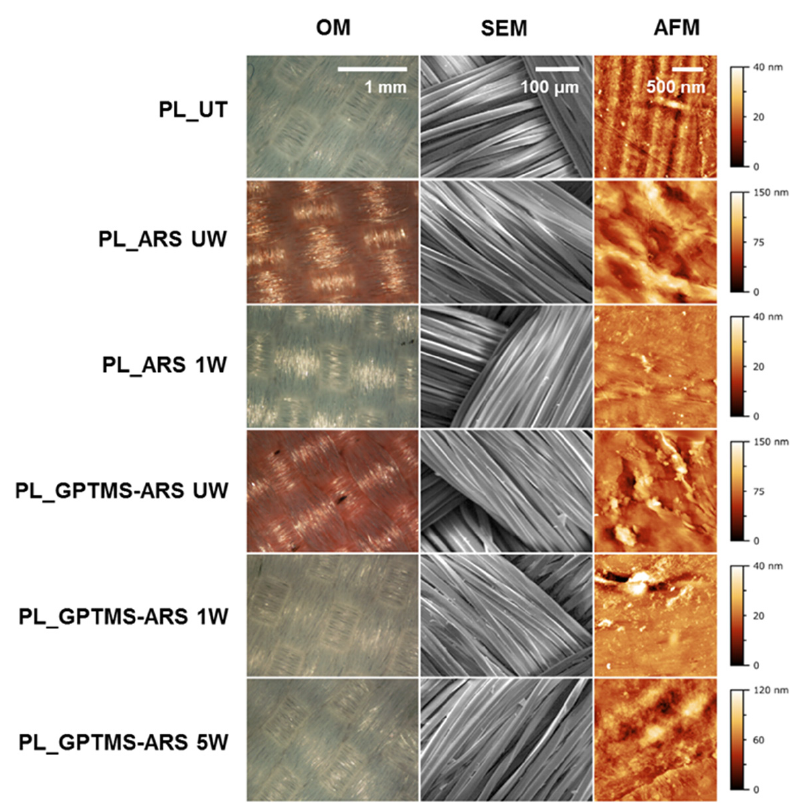
Figure 3. Images of developed halochromic polyester fabrics with Optical Microscopy (OM), Scanning Electron Microscopy (SEM) and Atomic Force Microscopy (AFM).